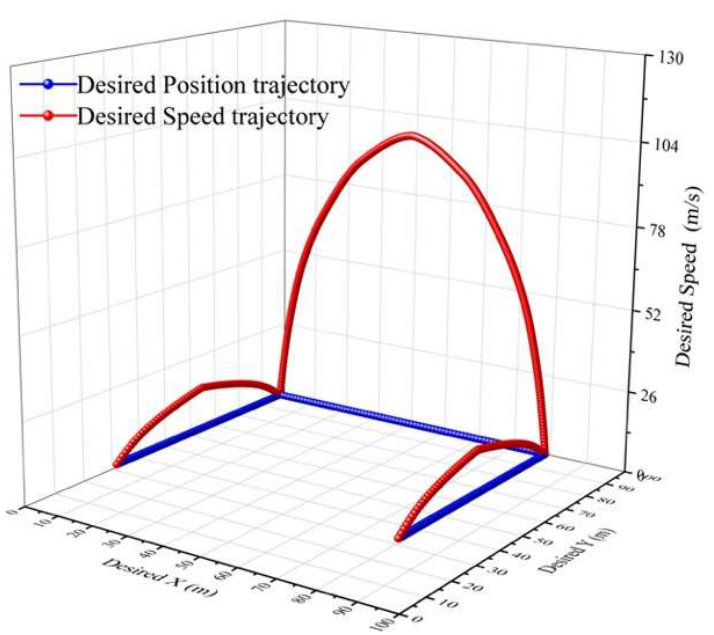
Figure 11. Speed and position trajectory.